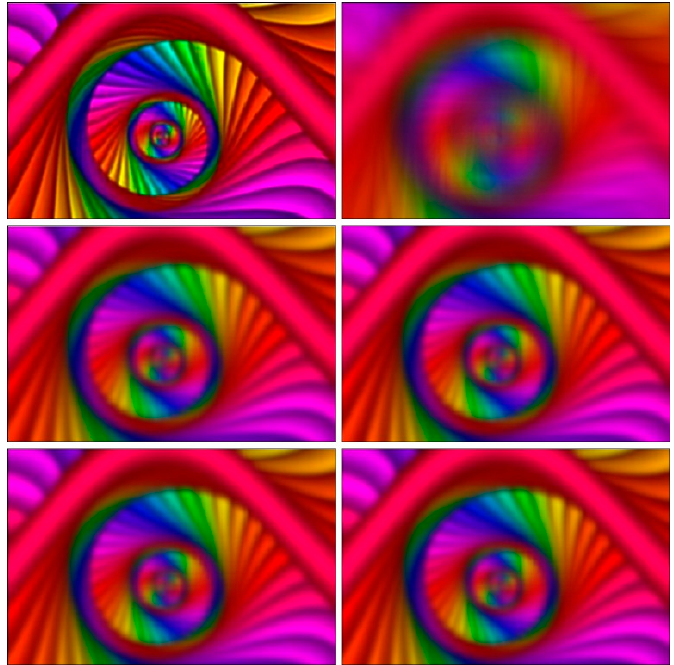
Figure 14. Simulation of image formation for a lens without apodization (upper row) and with phase apodization n = 3 (middle row) and n = 4 (lower row) in the focal plane z = f = 100 mm (left column) and outside the focal plane z = 120 mm (right column).